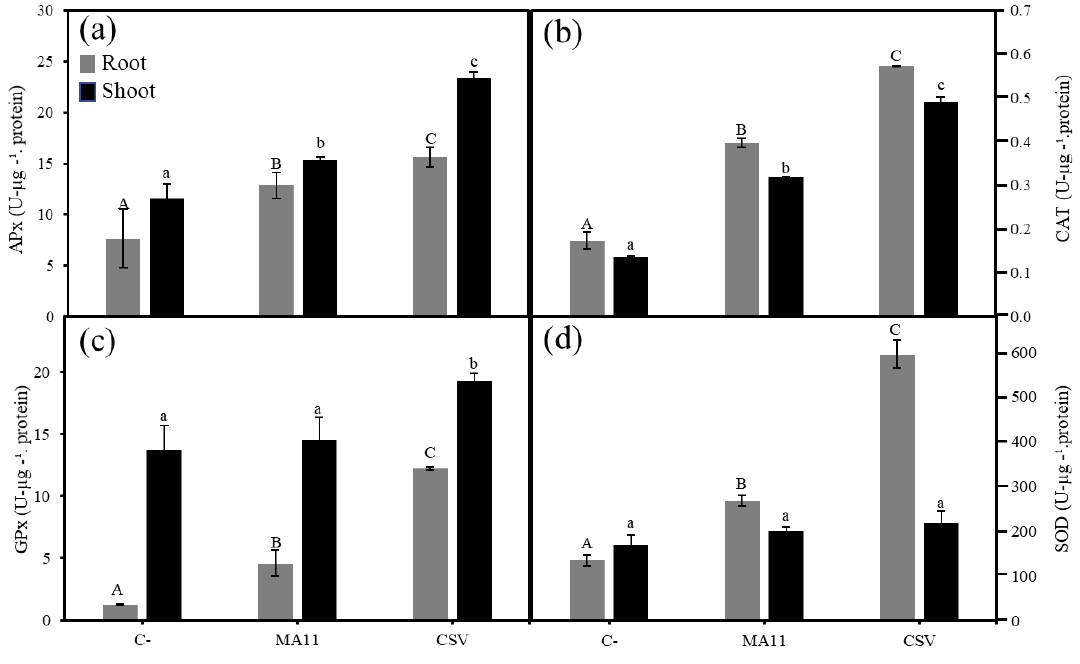
Figure 8. Antioxidant enzymes levels. ( a ) Ascorbate peroxidase, ( b ) catalase, ( c ) guaiacol peroxidase, and ( d ) superoxide dismutase activities in the leaves and roots of M. sativa after 60 days under greenhouse conditions with soil polluted with metals as substrate. Values are means ± S.D. ( n = 16). Different letters indicate means that are significantly different from each other (one-way ANOVA; LSD test, p < 0.0001). C – : non inoculation; MA11: inoculation with E. medicae MA11; CSV: inoculation